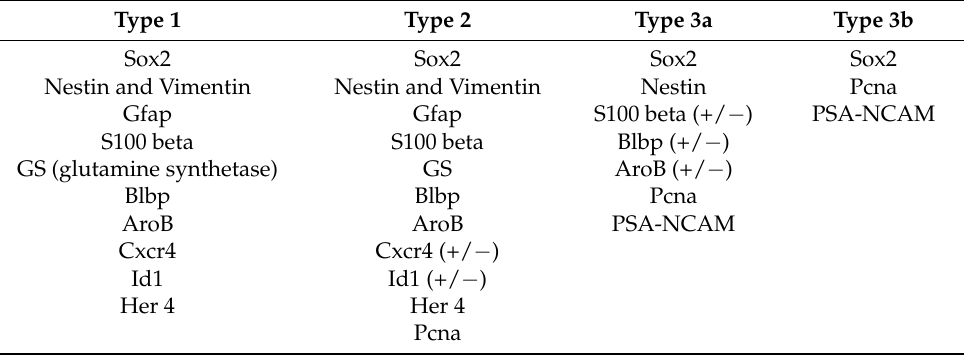
Table 1. Main markers expressed by type 1, 2, 3a, and 3b cells in the telencephalon of adult zebrafish. The (+/ − ) means that these markers are expressed at lower levels in the subtype. Type